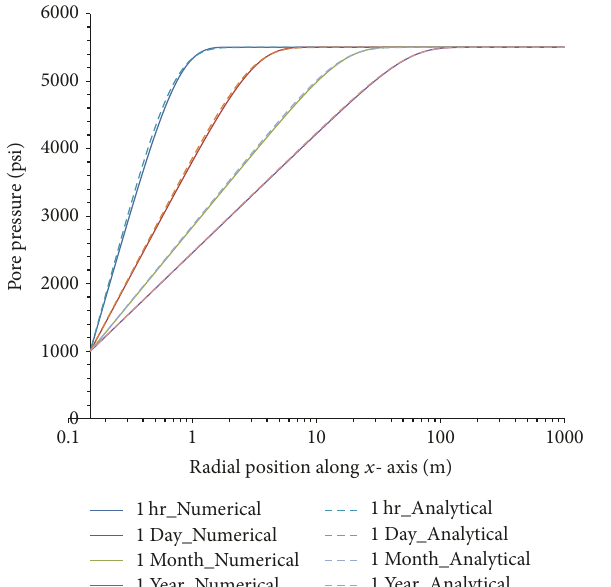
Figure 5: 𝑋 -component of radial stresses as a function of time in poroelastic medium with 𝜎 𝐻 = 5800 psi and 𝜎 ℎ = 5500 psi, 𝑃 𝑟 = 5500 psi, 𝑃 𝑤 = 1000psi, 𝑘 𝑥 = 0.01md, and 𝑘 𝑦 = 0.01md.